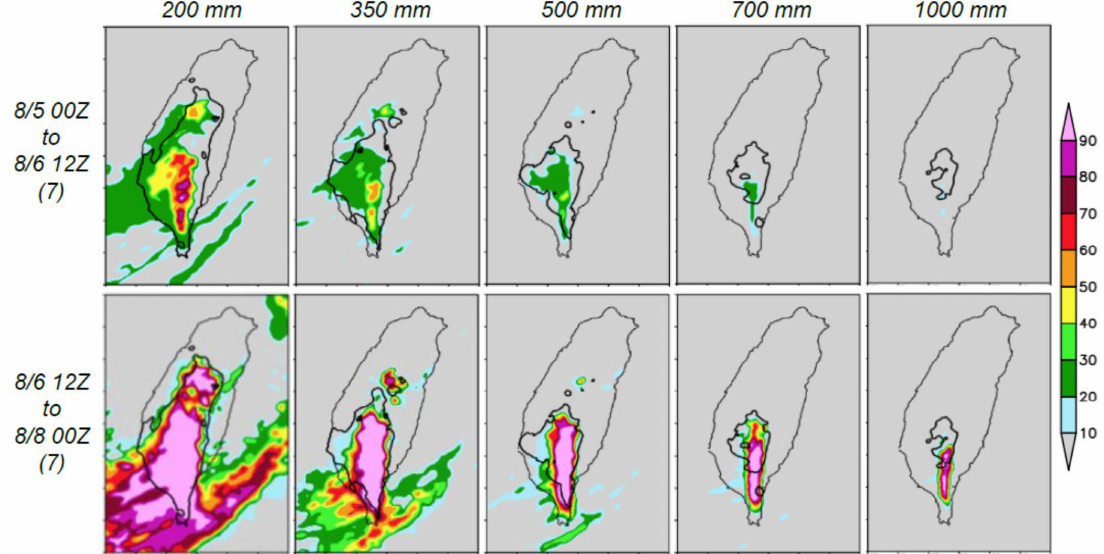
Figure 10. As in Figure 8, but for the probabilities of 24-h QPFs (%, color) from the seven members in Figure 9 with t 0 between ( top row ) 0000 UTC 5 and 1200 UTC 6 and ( bottom row ) 1200 UTC 6 and 0000 UTC 8 August (as labelled), to reach thresholds of 200, 350, 500, 700, and 1000 mm ( left to right ), respectively, for the target date of 8 August during TY Morakot (2009). The observed areas (over land) at the respective threshold are depicted by the thick black contours. The weights of members are the same as those in Figure